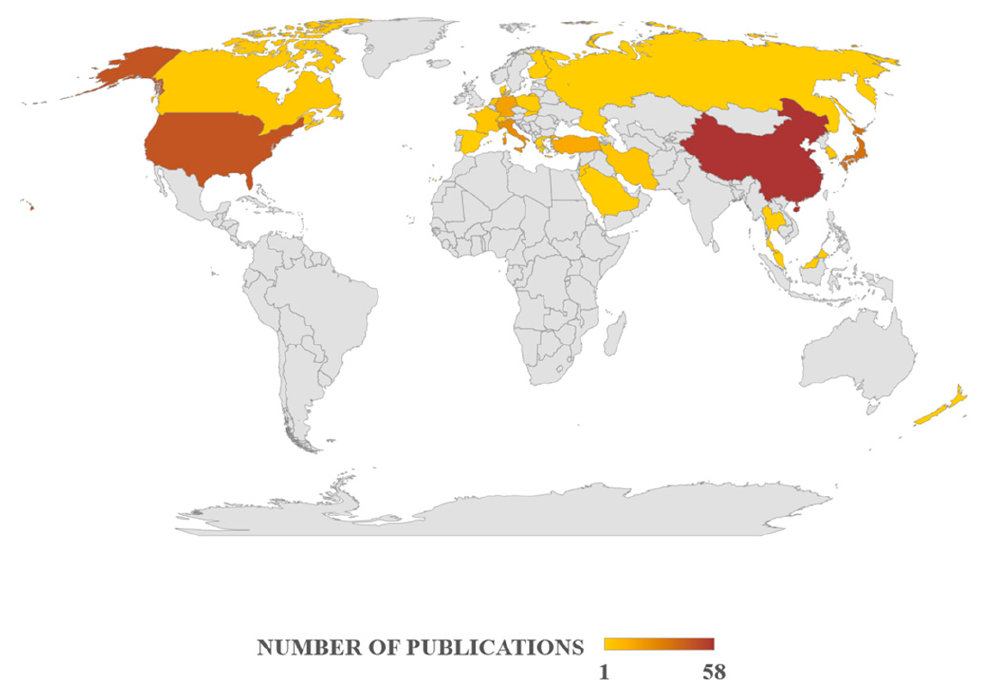
Figure 33. Distribution of scientific papers across the world.